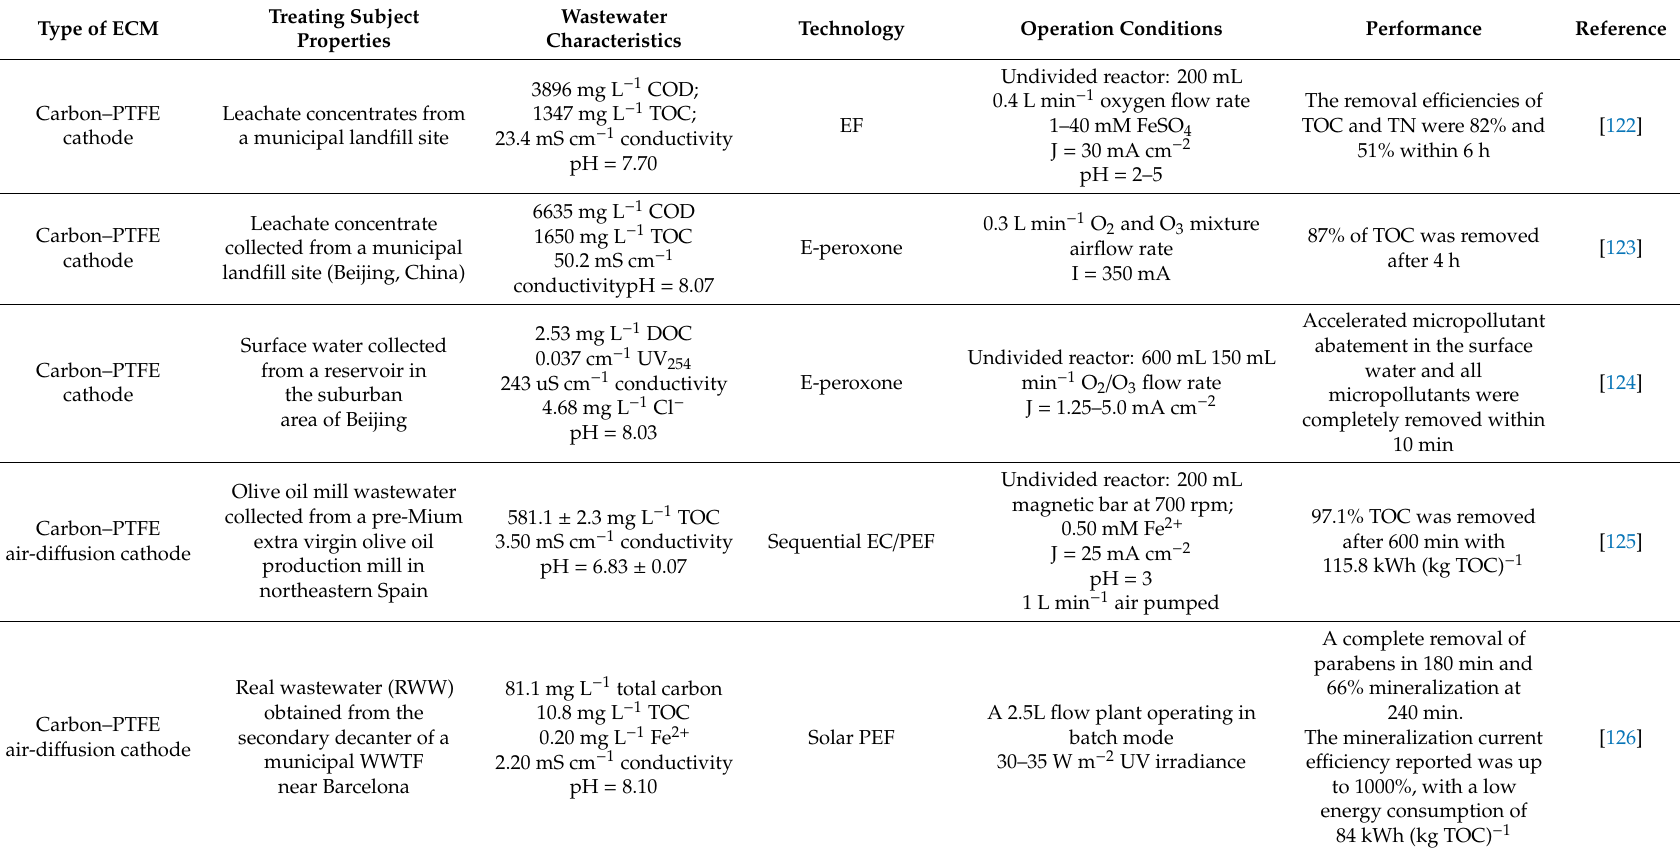
Table 3. Recent studies of application of electrochemical cathodic membranes